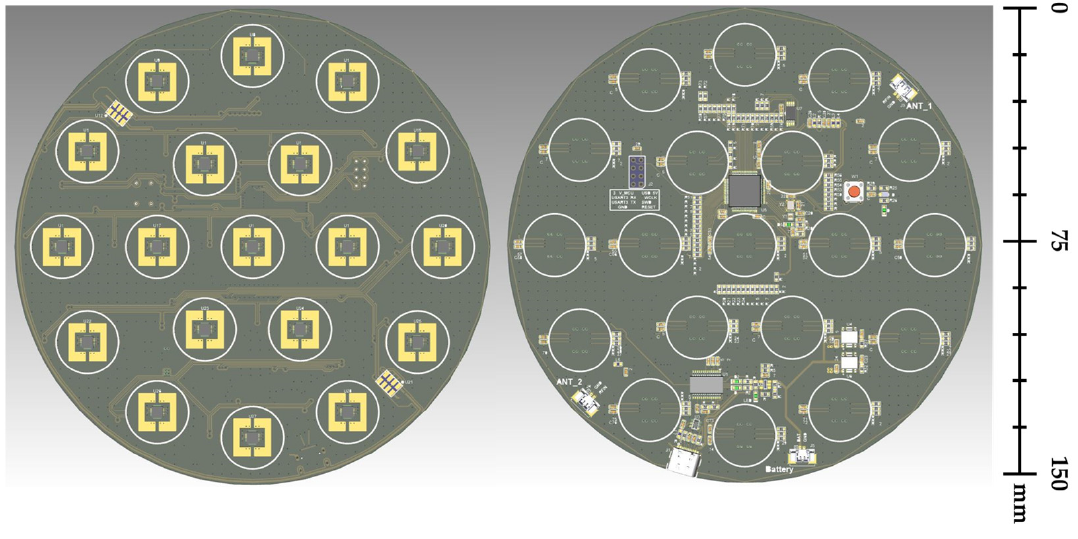
Figure 5. Hardware design of IEMS.